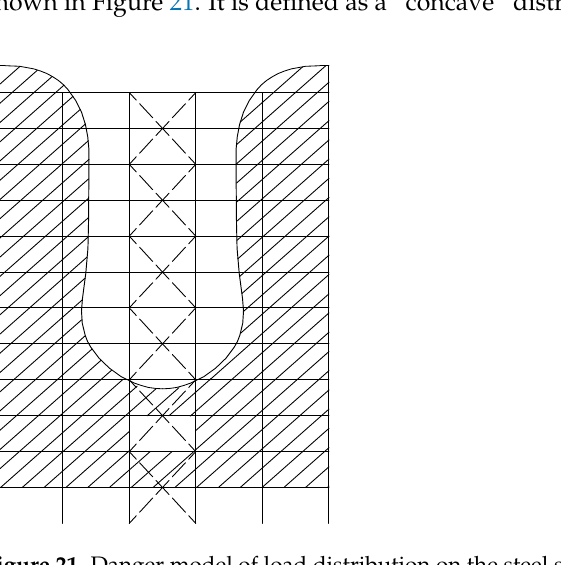
Figure 20. Load distribution hazard models for the steel storage racks with bracings.